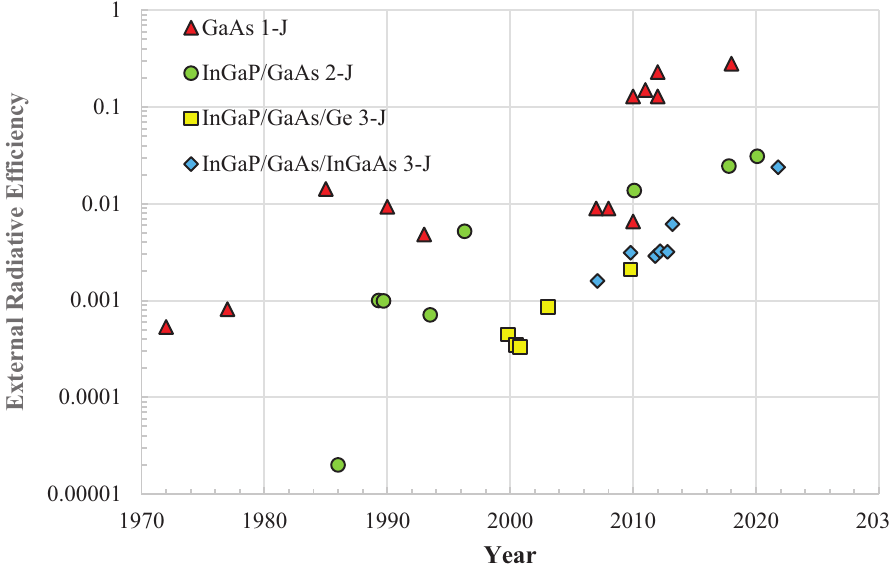
Fig. 4. Chronological ERE improvements of GaAs single-junction, III – V 2-junction, III – V/Ge 3-junction and III – V/InGaAs 3-junction solar